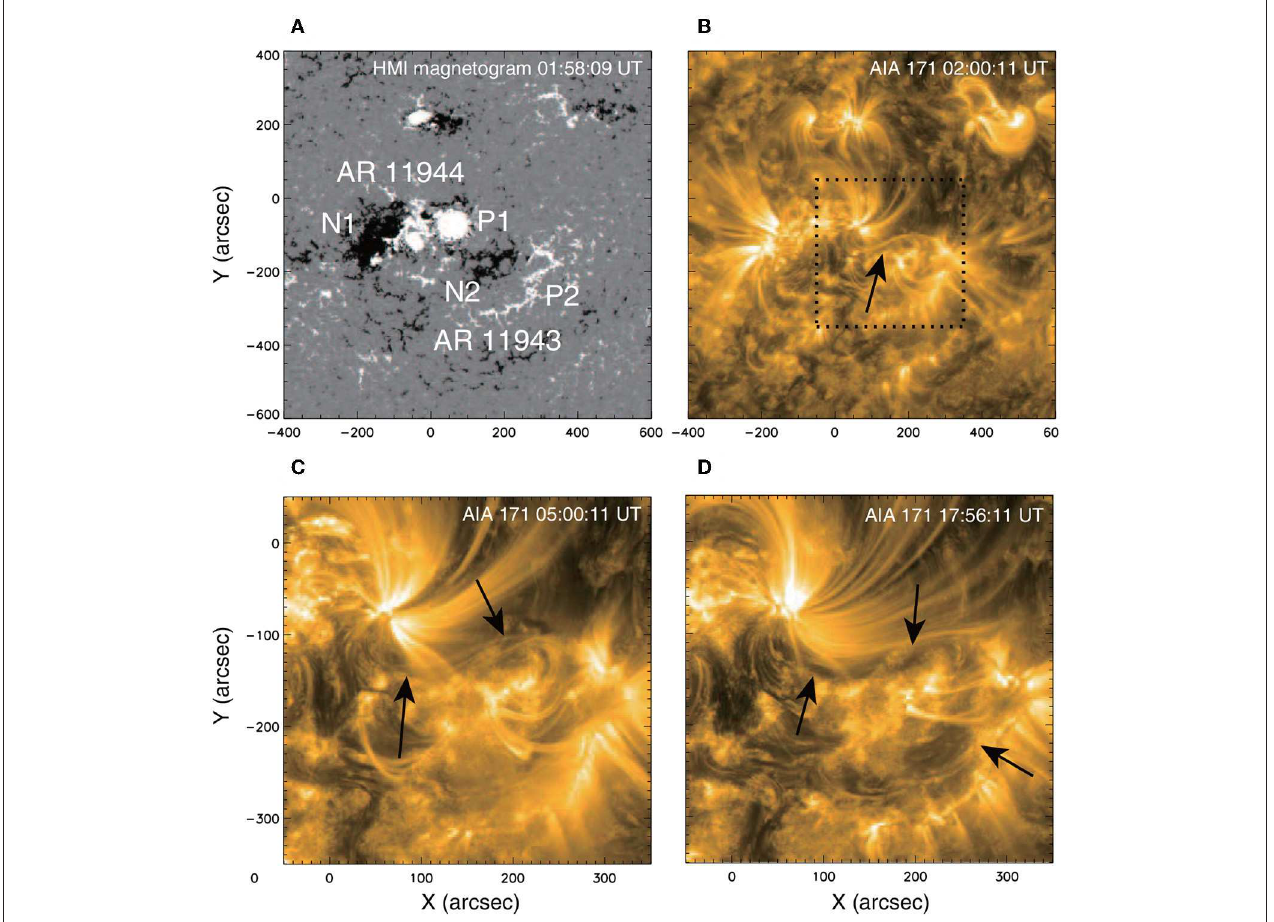
FIGURE 2 | (A) SDO /HMI magnetogram showing the distribution of magnetic polarities around the flare site. The main polarities are labeled as N1 and P1, which constitute AR 11944, and N2 and P2, which constitute AR 11943. The flare occurred mainly in association with P1 and N2. (B) SDO /AIA 171 Å image of the same field view of (A) . The arrow remarks a sigmoidal coronal loop in the flare site. (C) Enlarged view of the sigmoid as well as a filament as denoted by the arrows. (D) The filament channels as denoted by the